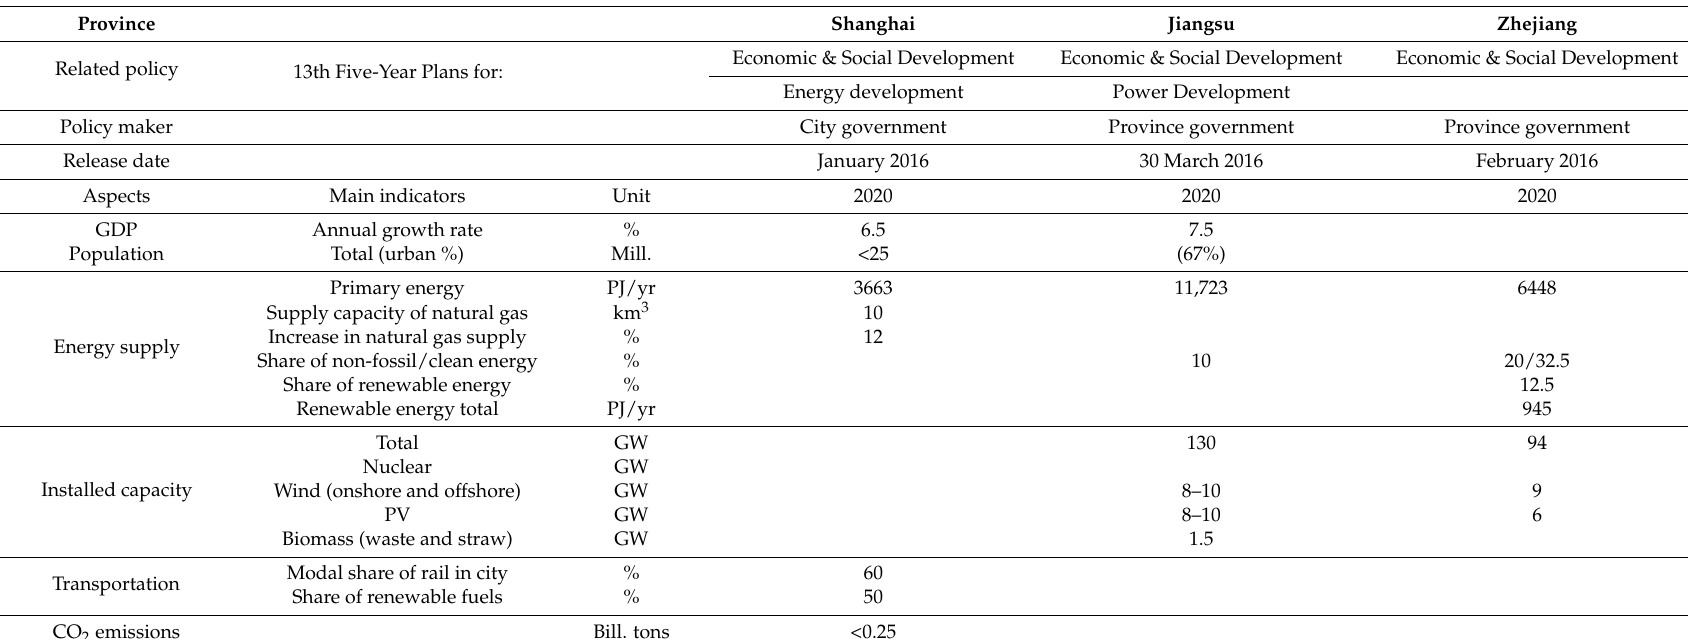
Table 5. Energy transition–related targets in Shanghai, Jiangsu, and Zhejiang